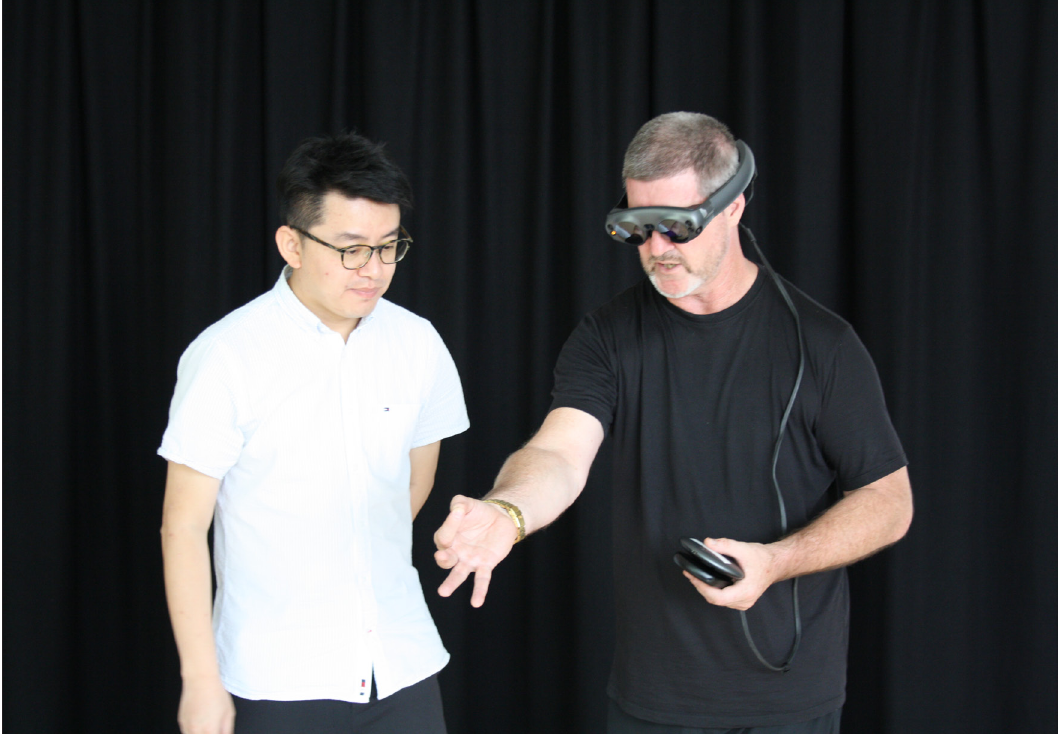
Figure 2: Exploring Augmented Reality in an early